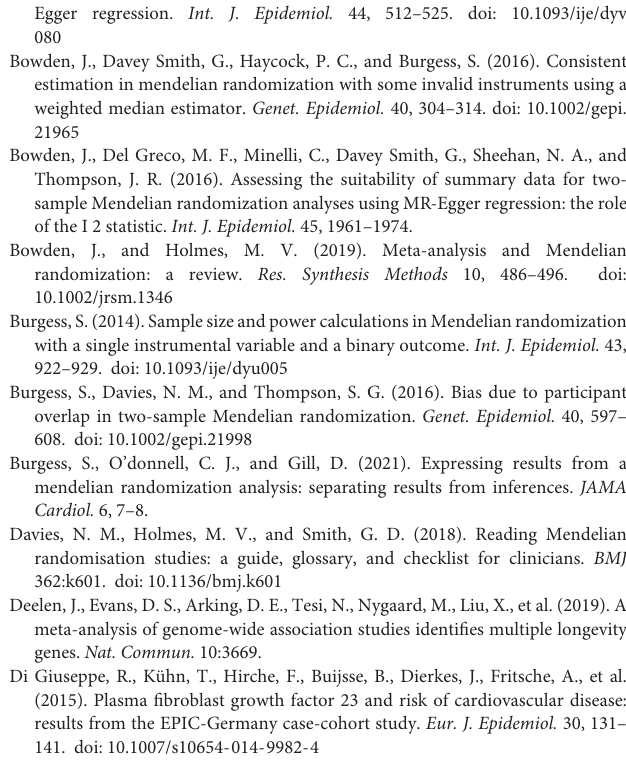
Supplementary Figure 1 | Study design of this Mendelian randomization study of genetically predicted FGF23 and cardiovascular diseases, their risk factors, kidney function, and longevity. Supplementary Figure 2 | Power estimates for this Mendelian randomization study of FGF23 in major cardiovascular outcomes. Supplementary Figure 3 | The associations of genetically predicted FGF23 and major cardiovascular diseases using Mendelian randomization, including the rs2769071 in ABO gene. Supplementary Figure 4 | The associations of genetically predicted FGF23 on cardiovascular risk factors, kidney function, and longevity using Mendelian randomization, including the rs2769071 in ABO gene. Supplementary Table 1 | Genetic predictors of log-transformed FGF23. Supplementary Table 2 | Genetic associations of major CVDs, their risk factors, kidney function, and longevity. Supplementary Table 3 | Genetic associations of CVDs and T2DM in FinnGen